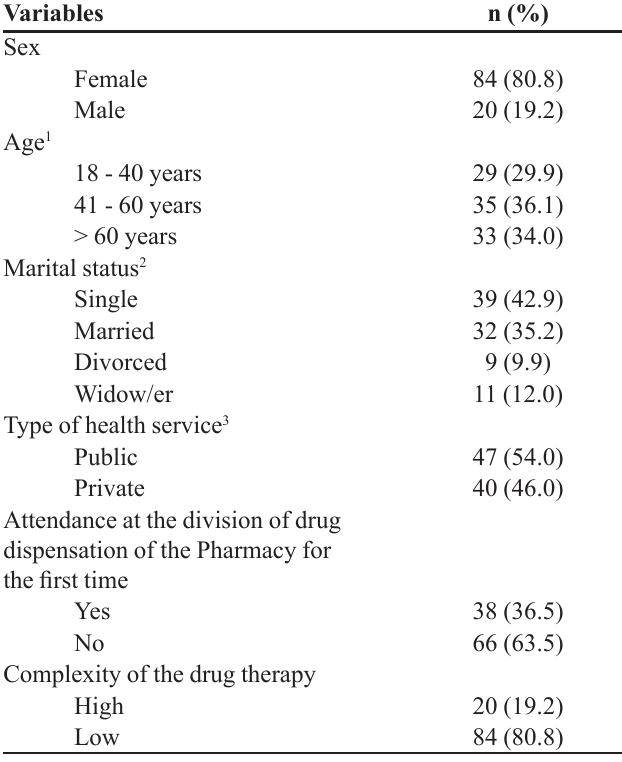
TABLE I – Characteristics of patients attending the medication dispensation division at the University Pharmacy of the Federal University of Goias, 2013 (n=104)